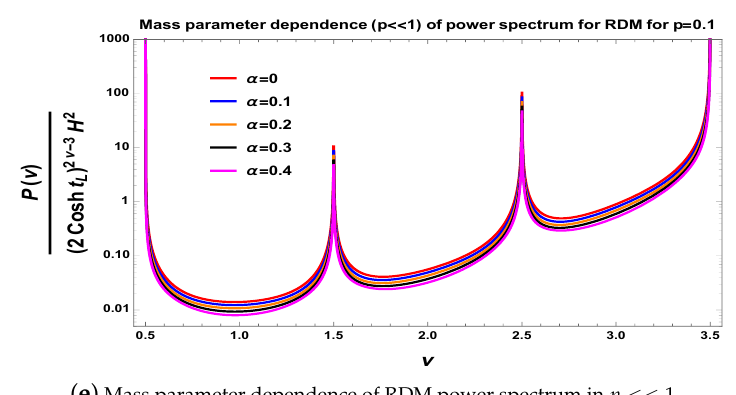
( c ) Small wave number dependence of RDM power spectrum for α = 0.1 and ν = 1,2,3,4,5.